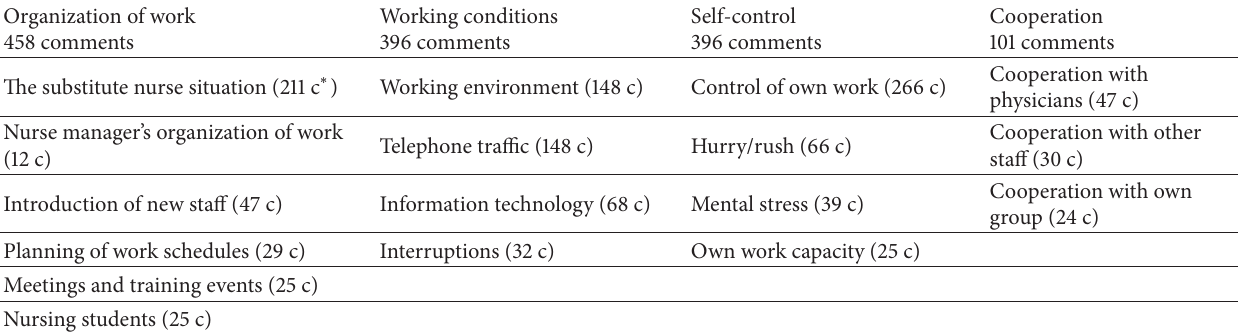
Table 1: Nonpatient factors that affect total NWL, described as categories and